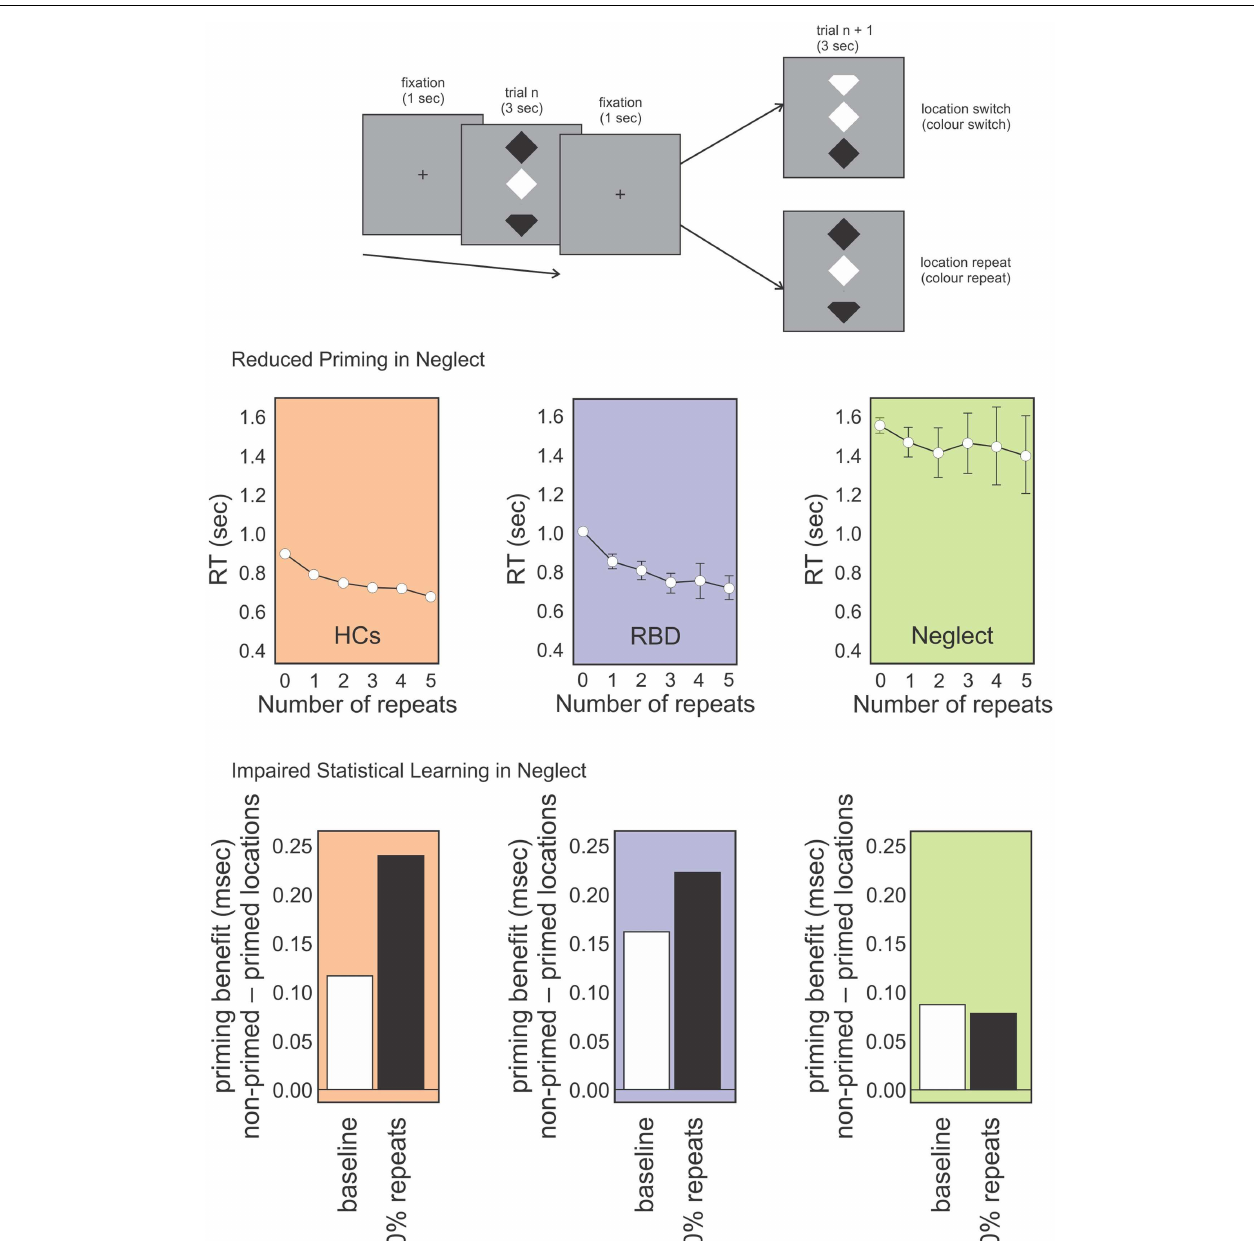
reduced priming relative to HCs who show increased priming over all five trials. In contrast, Neglect patients show no priming benefit after trial 1. Lower panel: priming benefit in conditions where repeated locations and switched locations are equally likely (baseline; white bars) vs. conditions in which location repeats were highly probably (i.e., location repeated on 80% of trials). Controls and RBD patients show an increased priming benefit on the highly probable repeat trials whereas Neglect patients do